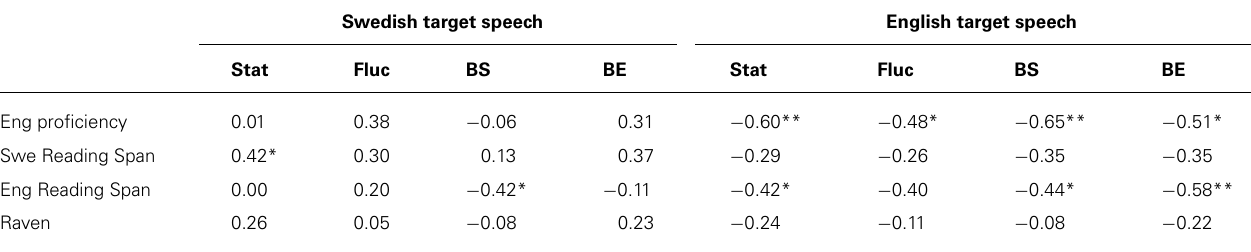
Table 3 | Spearman correlation between several test outcomes/abilities and the SRTs in the eight conditions.